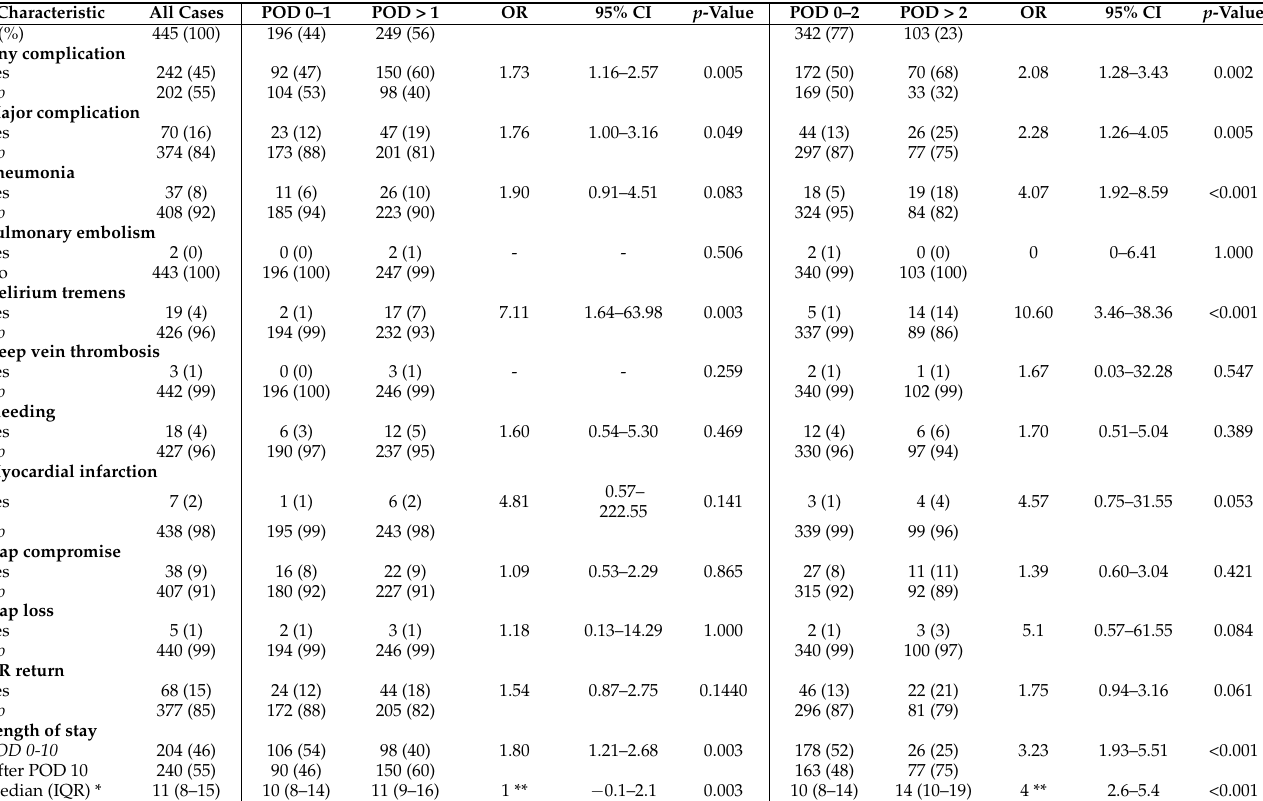
Table 2. Postoperative mobilization time, complications, and length of stay. The reference level for odds ratios is indicated with italics